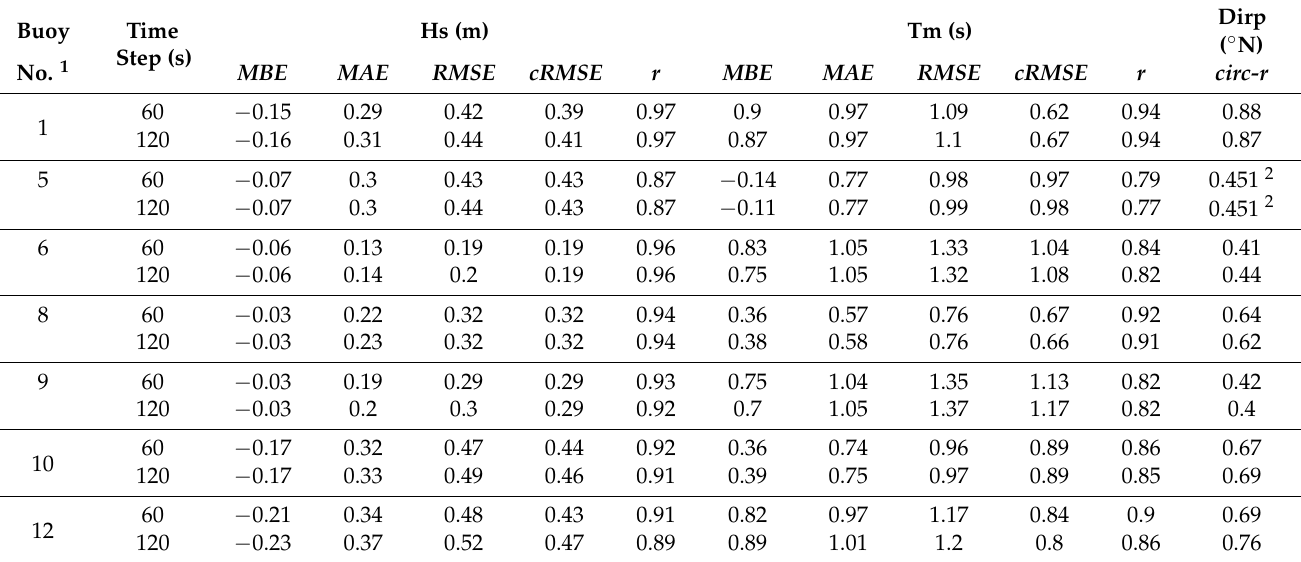
Table 5. Statistical indicators for Hs, mean wave period (Tm) and peak wave direction (Dirp) (or mean wave direction (Dirm)), evaluated for time steps equal to 120 and 60 s with ST4 source term parameterization and explicit N scheme.